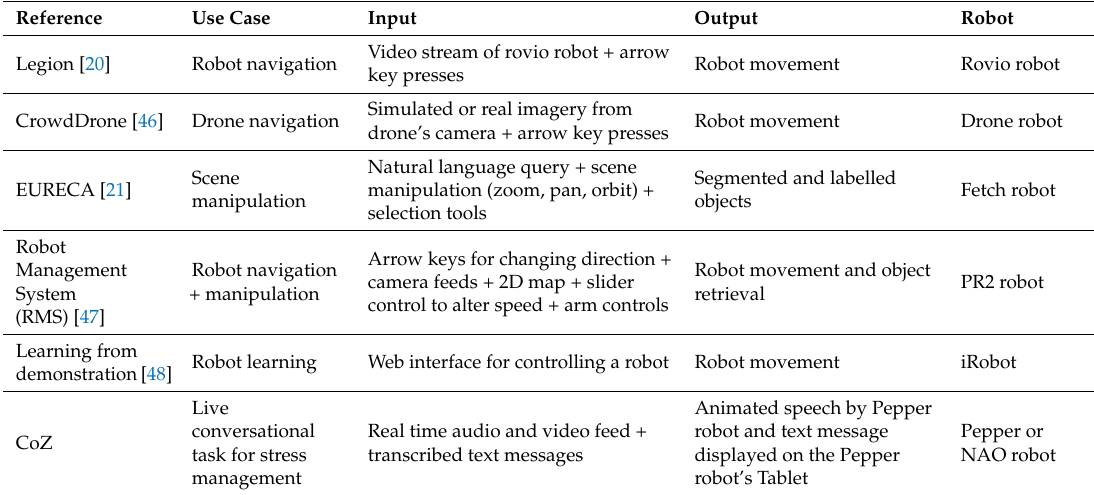
Table 2. Summary of the key differences between CoZ and other systems from crowd or web